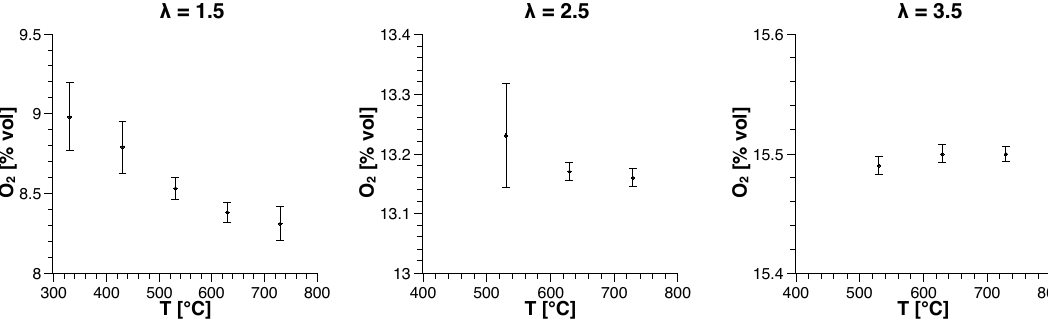
Figure 7. O 2 concentration (% vol) in the exhaust gases as a function of the air inlet temperature for different values of the air-to-fuel ratio λ .